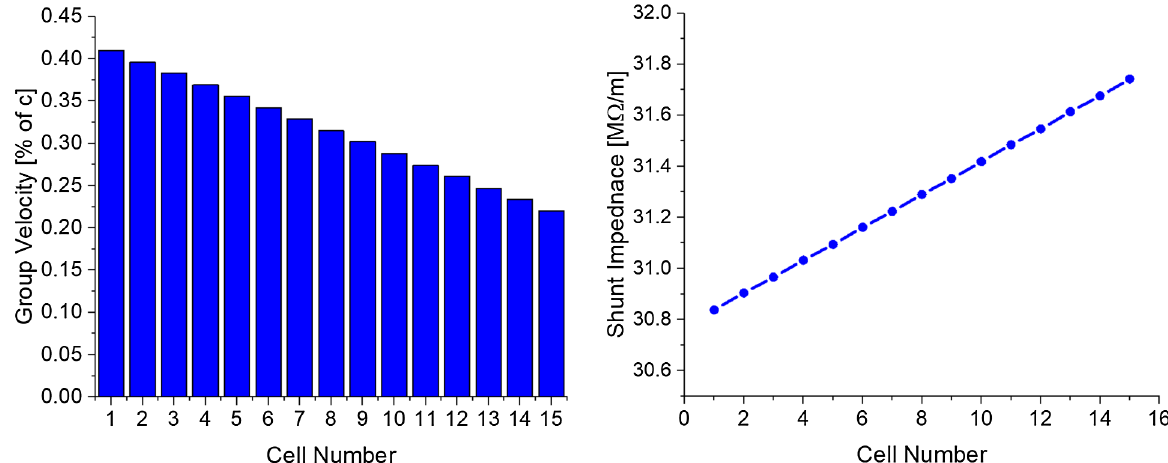
FIG. 15. Group velocity (left) and shunt impedance (right) variation in the cells along the structure.